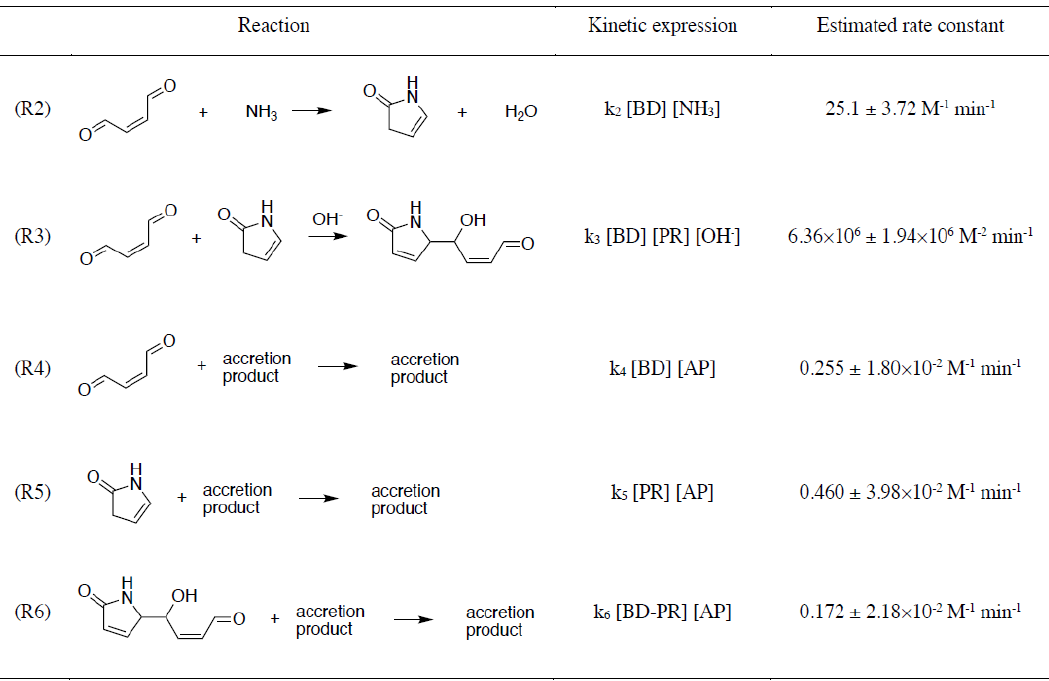
Table 3. Reactions in the butenedial/NH x model kinetic mechanism, their rate laws as expressed in the mechanism, and corresponding estimates of the rate constants and their standard